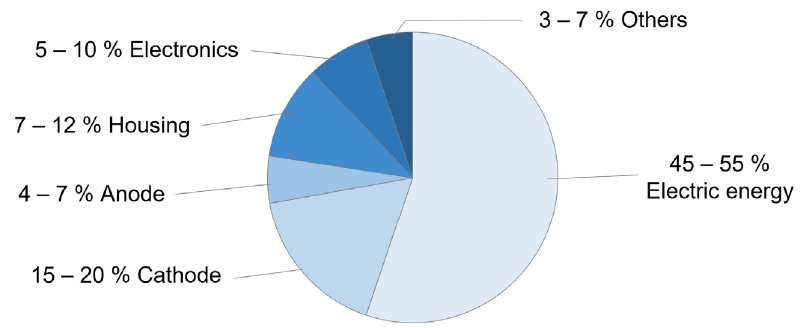
Figure 13. CO 2 -equivalent-emission impacts of battery-manufacturing-related factors.